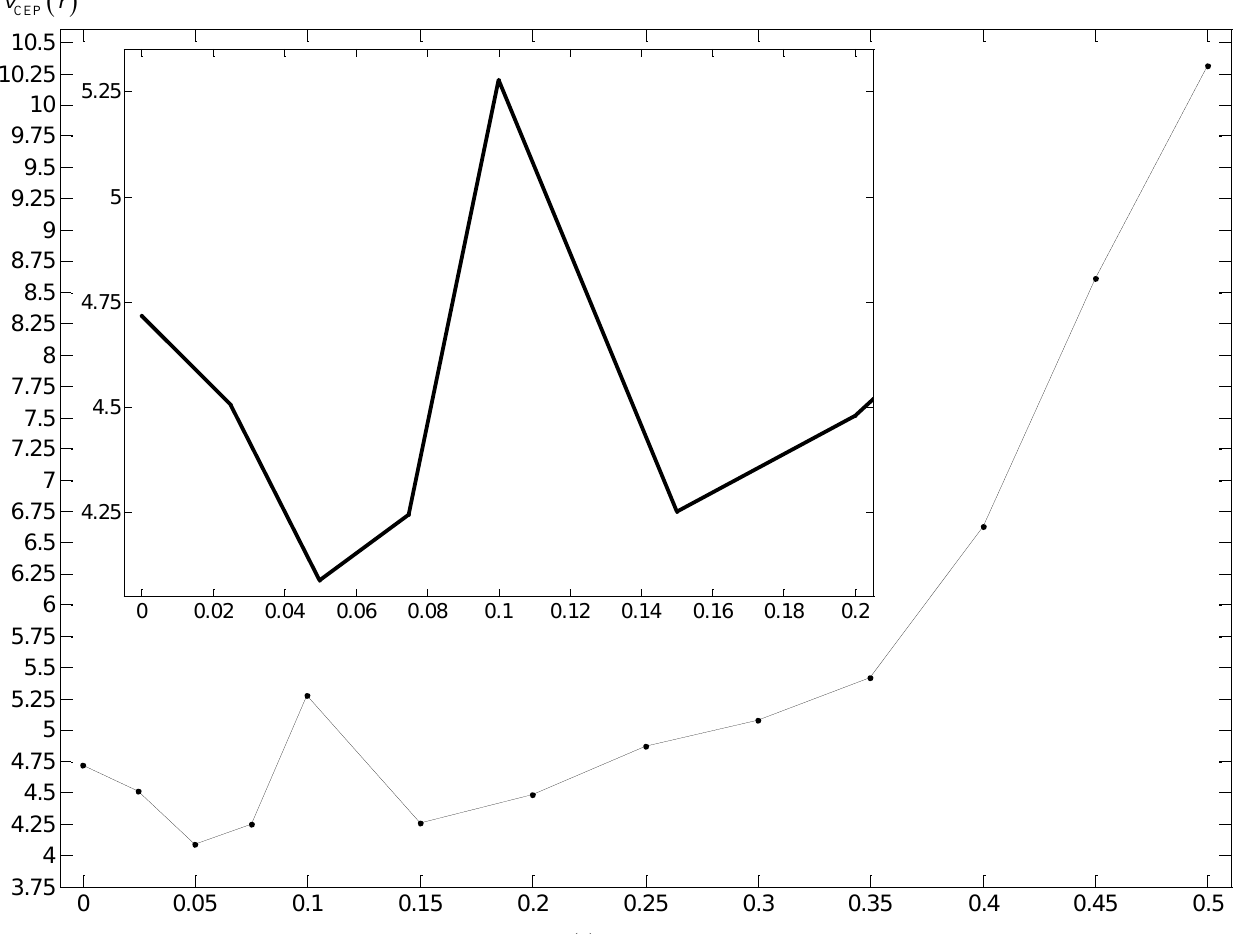
Fig. 4. Evaluation of the function  